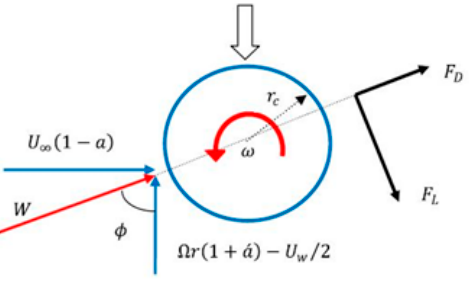
Figure 9. Forces and wind velocity over the spinning element due to Magnus Effect [113].